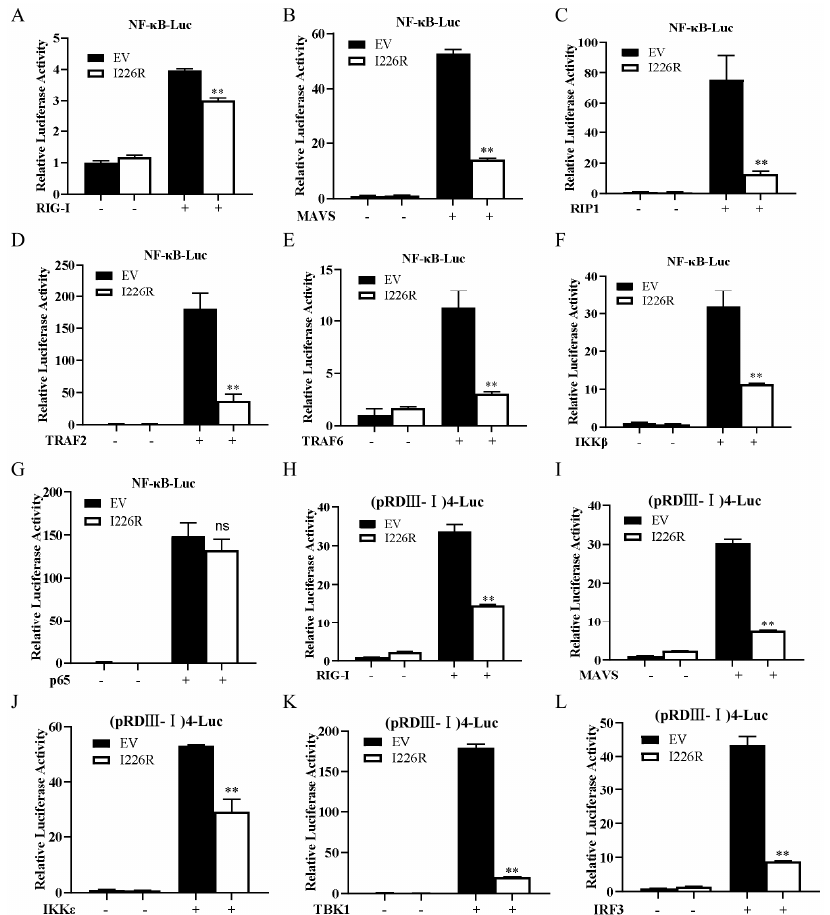
Figure 6. The I226R protein inhibits NF- κ B through targeting the IKK complex: ( A – G ) 293T cells were co-transfected with 500 ng NF- κ B-Luc, 50 ng pRL-TK, and 500 ng I226R-Flag or EV, along with 300 ng RIG-I ( A ), MAVS ( B ), RIP1 ( C ), TRAF2 ( D ), TRAF6 ( E ), IKK β ( F ), or p65 ( G ). Luciferase activity